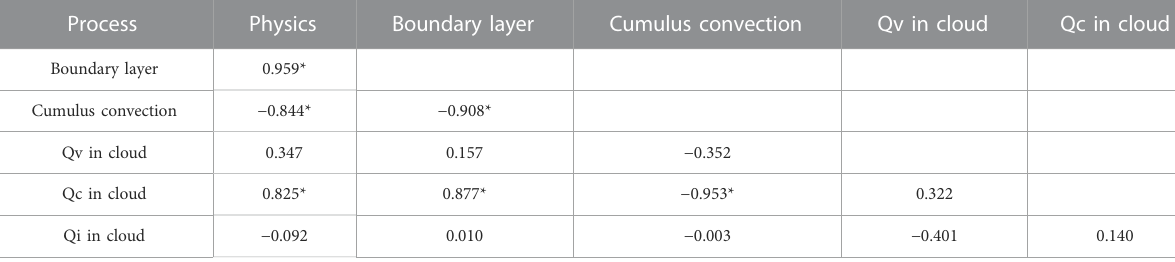
TABLE 2 Correlation coef fi cients of the vapour tendencies for each process in the winter.